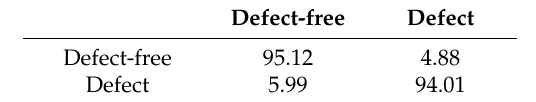
Table 5. Confusion matrix of the DCNN DND after evaluation update procedure [%].